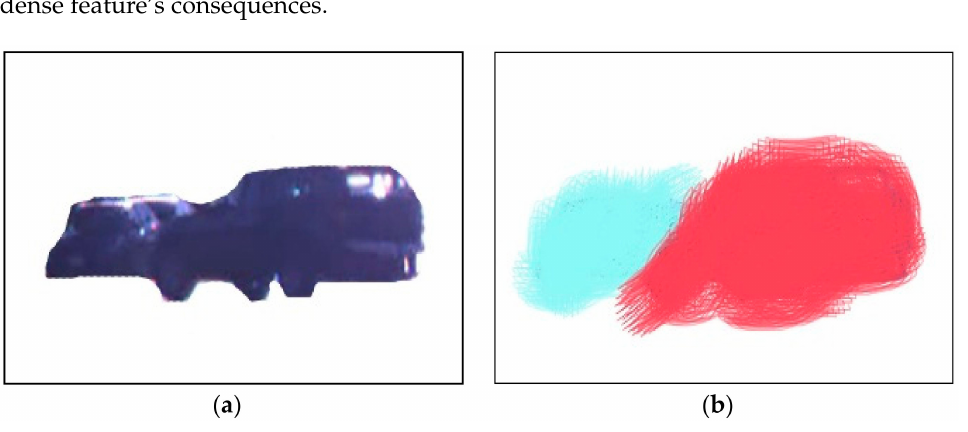
Figure 7. Example results of dense optical flow features: ( a ) background-subtracted image and ( b ) example results of dense optical